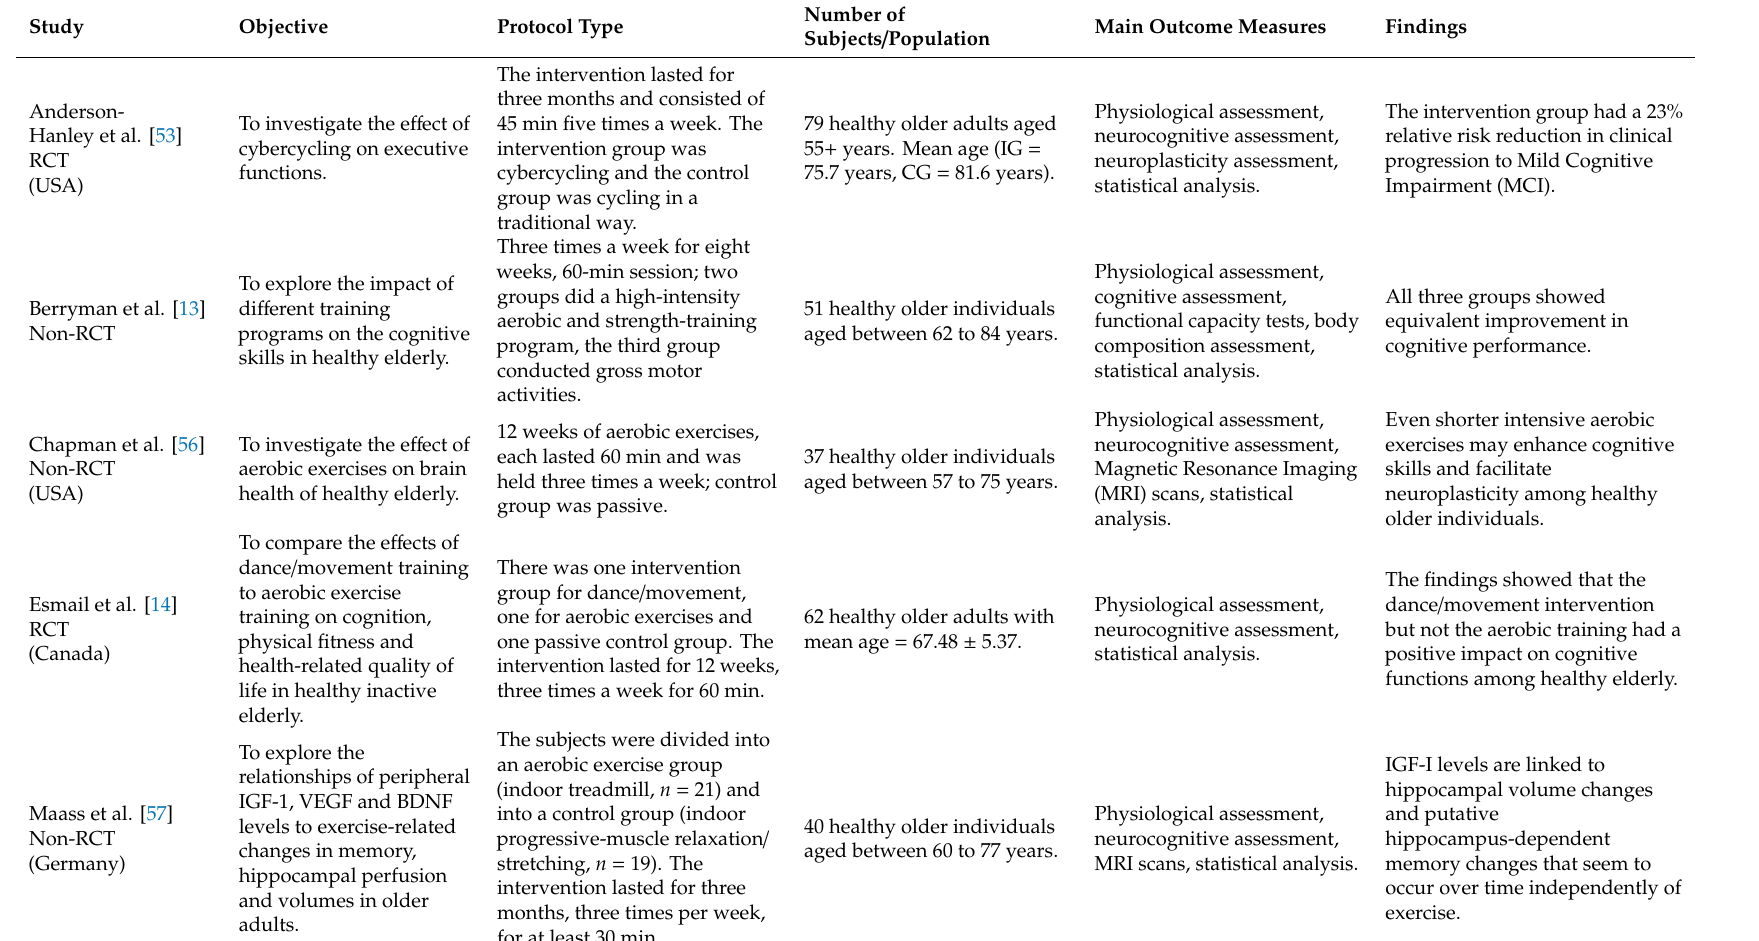
Table 1. Overview of the findings from eight detected studies on the impact of physical activities on cognitive functions among healthy older individuals (authors’ own